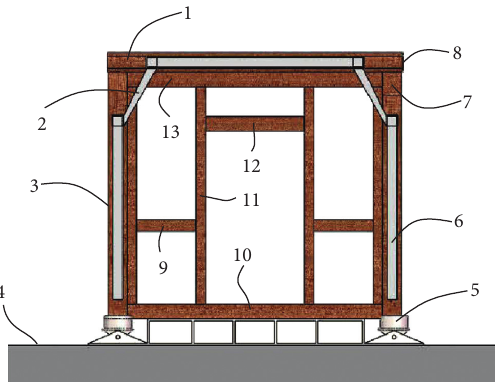
Figure 1: Component of the reinforced wooden door frame. Note: